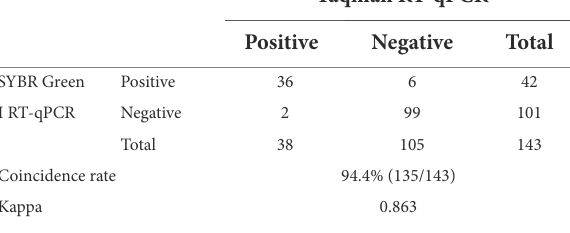
TABLE 2 Comparison of SYBR Green I RT-qPCR and Taqman RT-